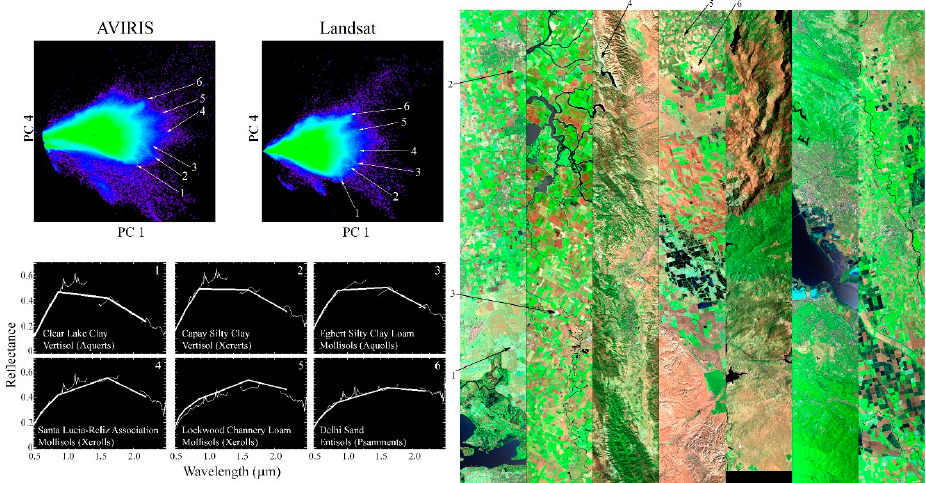
Figure 7. AVIRIS and Landsat substrate EM variability. The PC 1 vs. 4 projection is useful in both transforms as a means of discriminating between the spectral shape of substrate EMs. The remarkable topological similarity between the AVIRIS and Landsat feature spaces ( upper left ) extends into the fourth dimension. The bright (high PC1) edge of the point cloud splays out in both AVIRIS and Landsat to reveal a continuum of rock and soil substrate EM spectra. Multipixel mean spectra for each of these EMs ( lower left ) are displayed as observed by both Landsat and AVIRIS. The locations of the spectra are indicated on the AVIRIS flight lines ( right ). USDA-NCSS soil survey data were used to find the soil type at the location of each EM. The order and suborder of each soil are shown on the EM spectra plots. The spectral variability captured by the EM continuum corresponds to consistent soil property variations. From EM1 to EM6, the soil types are characterized by a tradeoff between decreasing clay content and increasing sand content.